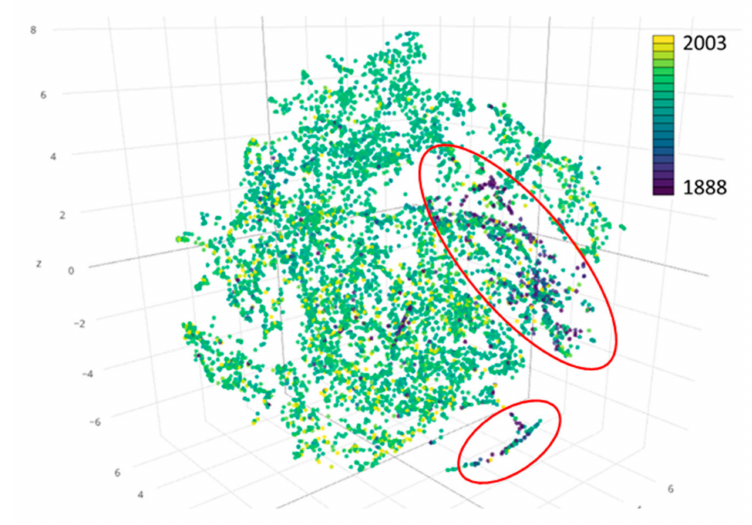
Figure 12. T-SNE visualization of the 6964 USGS maps in the state of Colorado in a 3D feature space based on 12-dimensional image descriptors obtained from channel-wise color